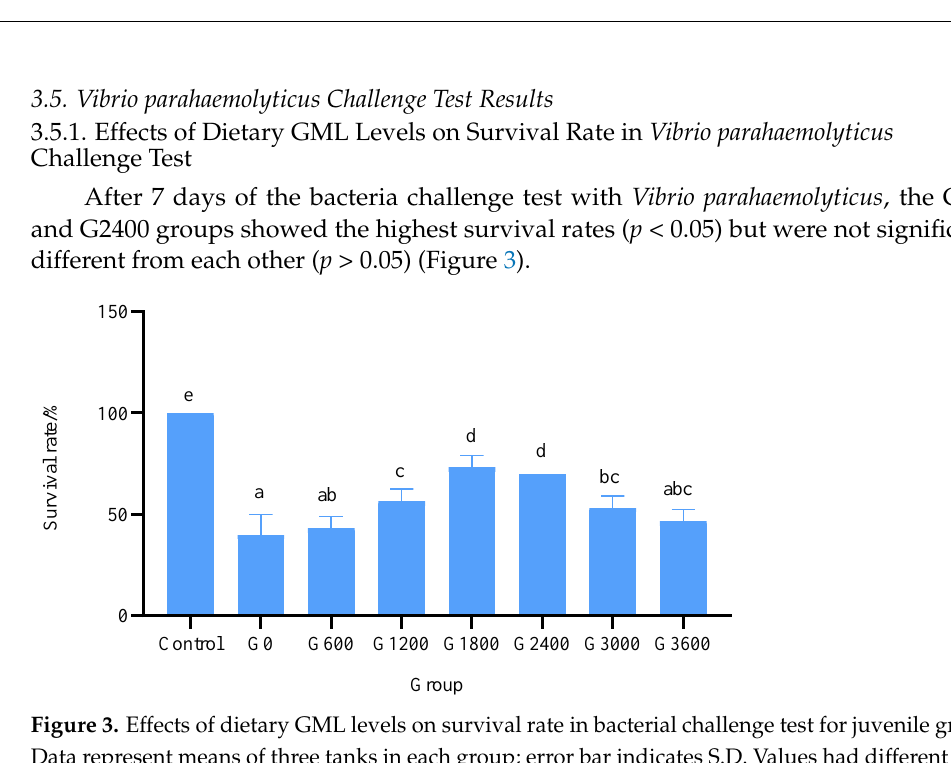
Figure 2. Effects of dietary GML levels on relative expressions of TLR2 , myd88 , TL- 1β , IL10 , and IL8 in head kidney inflammatory factors genes in bacterial challenge test for juvenile grouper. Data represent means of three tanks in each group; error bar indicates S. D. Values with different letters